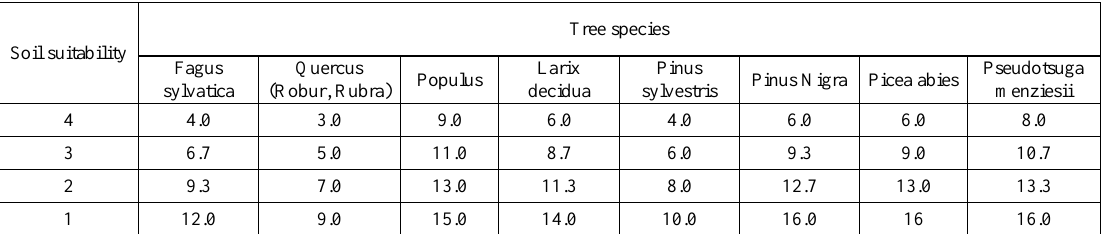
Table A1: Overview of the relationships between soil suitability and the maximal mean growth of stemwood (m³/ha*yr).